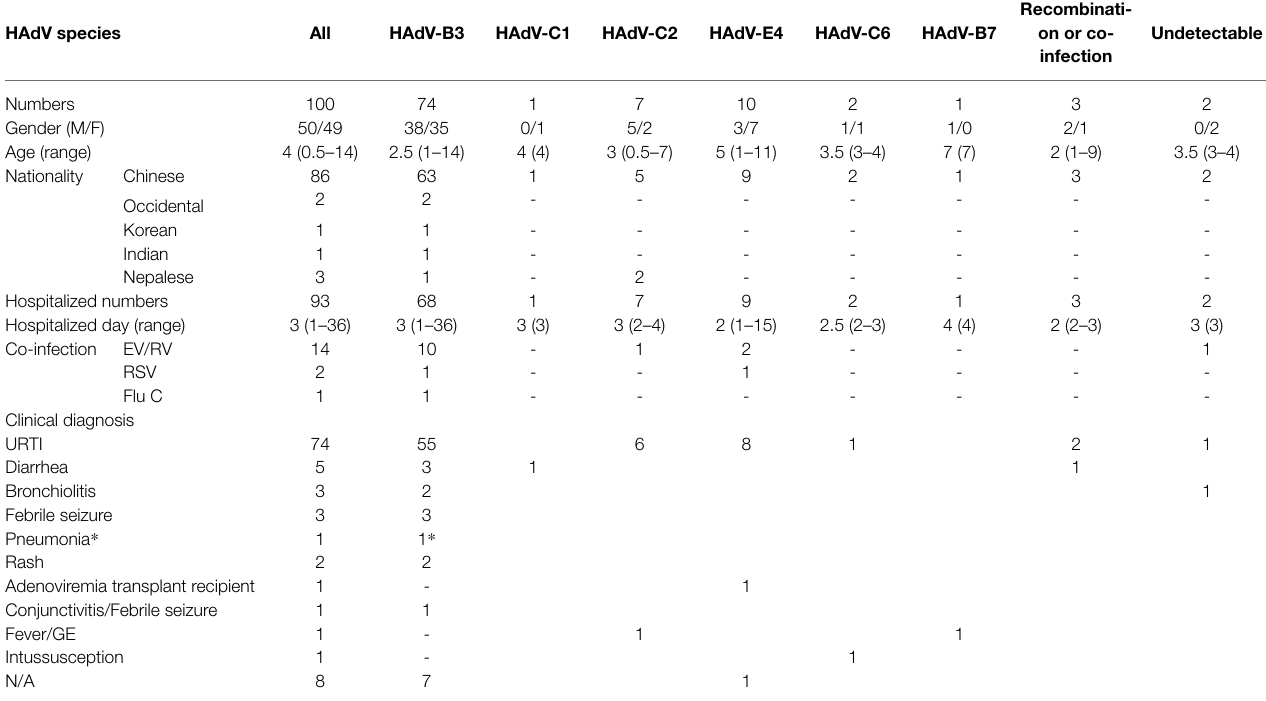
TABLE 2 | Comparison of demographic and clinical characteristics of 100 children with ARD according to HAdV type in Hong Kong, summer 2014.